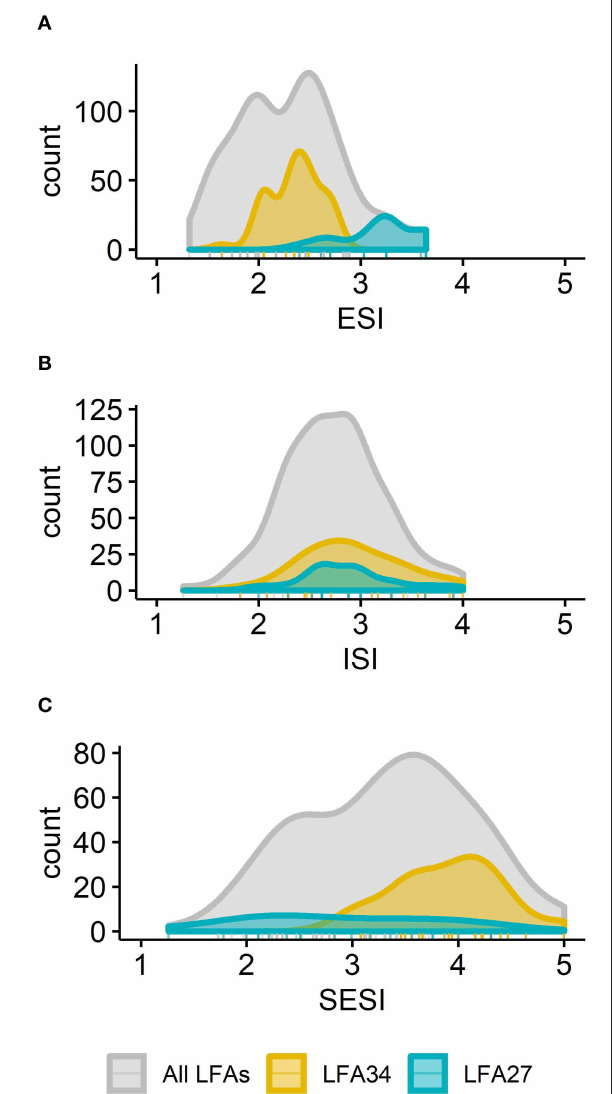
FIGURE 7 | Distributions of vulnerability sub-indices in Lobster Fishing Areas (LFA) 27 (blue) and 34 (yellow) compared to the distribution of all LFAs combined (gray). Plots are counts of Small Craft Harbors location scores for: (A) the Exposure Sub-Index (ESI), (B) Infrastructure Sub-Index (ISI), and (C) Socio-Economic Sub-Index